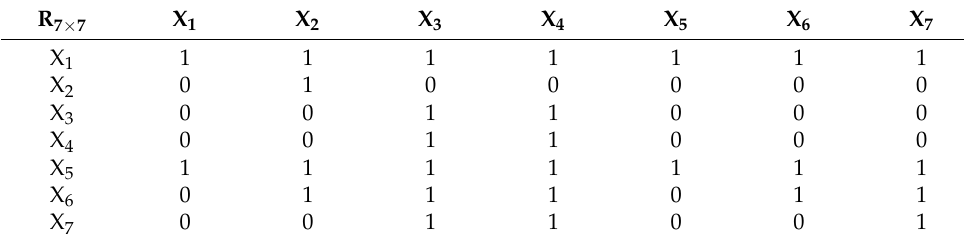
Table 6. The reachability matrix R.